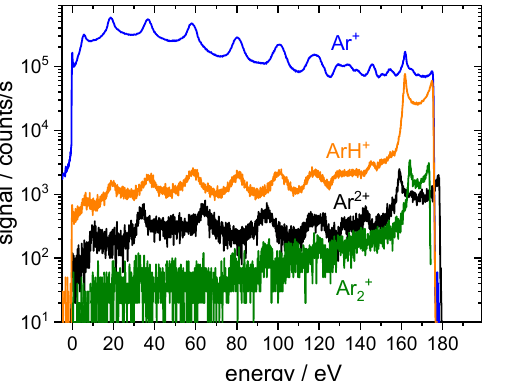
Figure 3. Measured IEDFs for argon-related ions in an Argon discharge at 2.5 Pa and 300 V pp